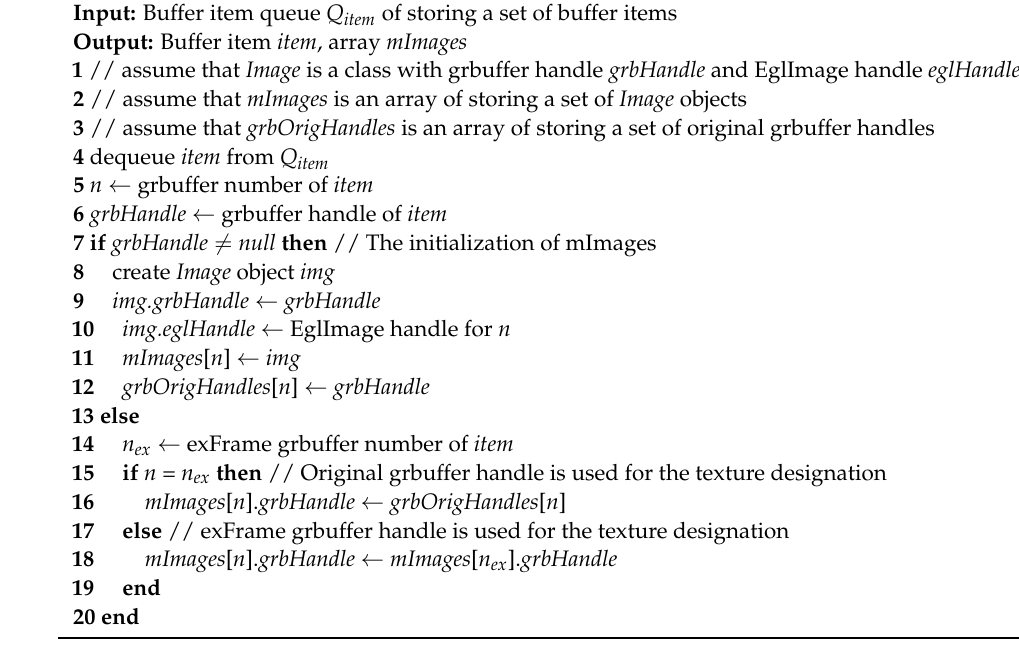
Algorithm 2. Algorithm of replacing a junk grbuffer handle of an mImages entry with an exFrame